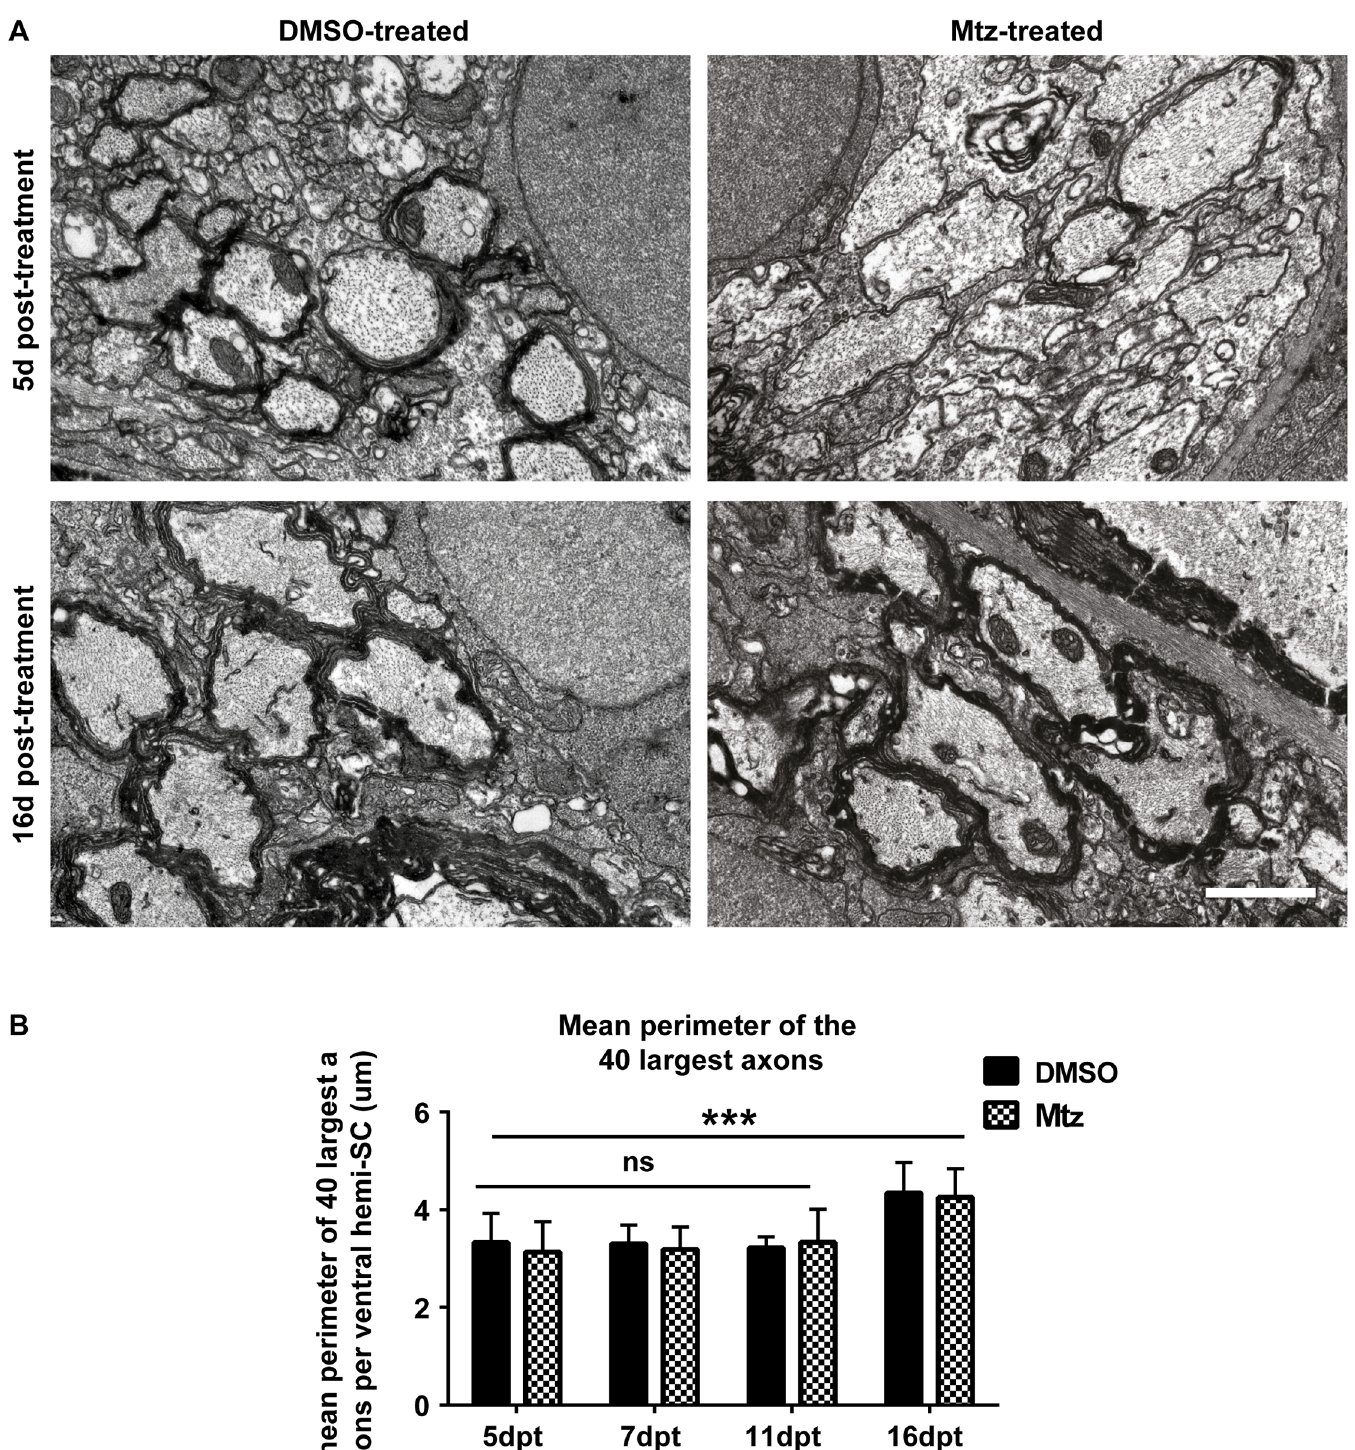
Fig 9. Remyelination coincides with growth of axon caliber between 5dpt and 16dpt. A . Top panel: representative electron micrographs from DMSO- and Mtz-treated Tg(mbp:mCherry-NTR) larvae at 5dpt. Bottom panel: same from larvae 16dpt. Scale bar: 1 μ m. B . Quantification of the mean perimeter of the 40 largest axons (whether myelinated or unmyelinated) in control and treated larvae at 5, 7, 11 and 16dpt. At 5dpt, mean perimeter of the 40 largest axons in controls: 3.32 μ m ± 0.60 μ m and treated 3.13 μ m ± 0.62 μ m. At 7dpt, controls 3.30 μ m ± 0.39 μ mand treated 3.19 μ m ± 0.46 μ m.At 11dpt,